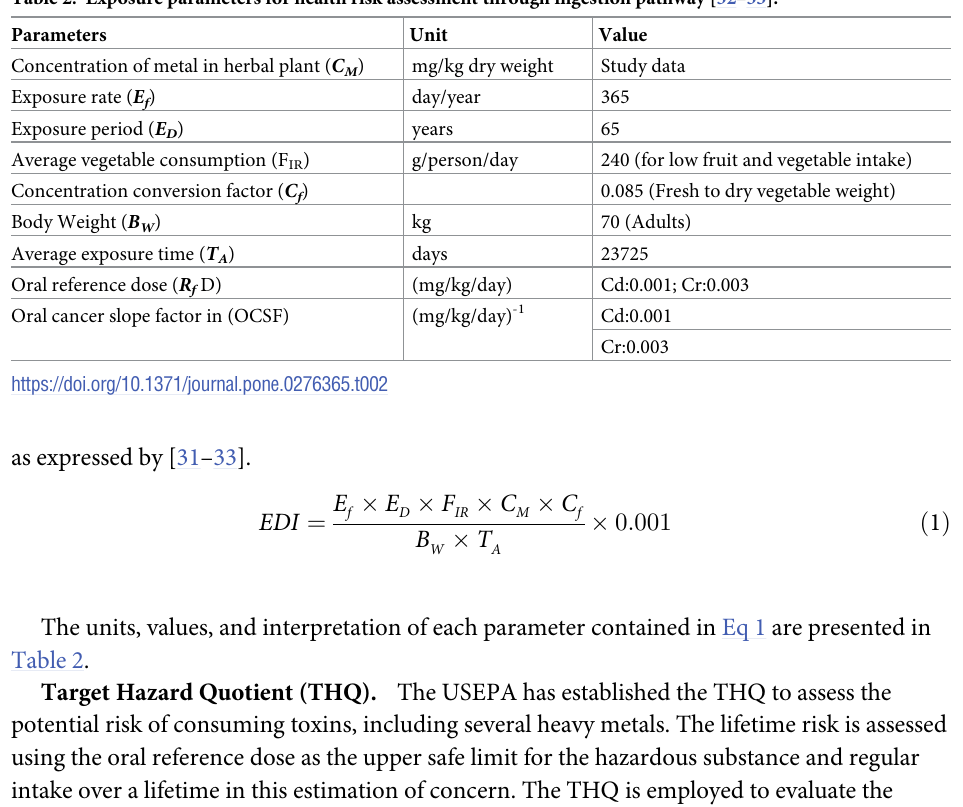
Table 2. Exposure parameters for health risk assessment through ingestion pathway